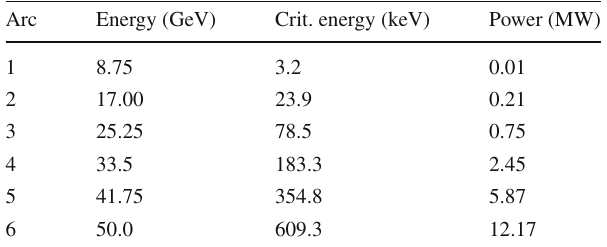
Table 3 Critical energy and power of the emitted synchrotron light in the return arcs of the ERL